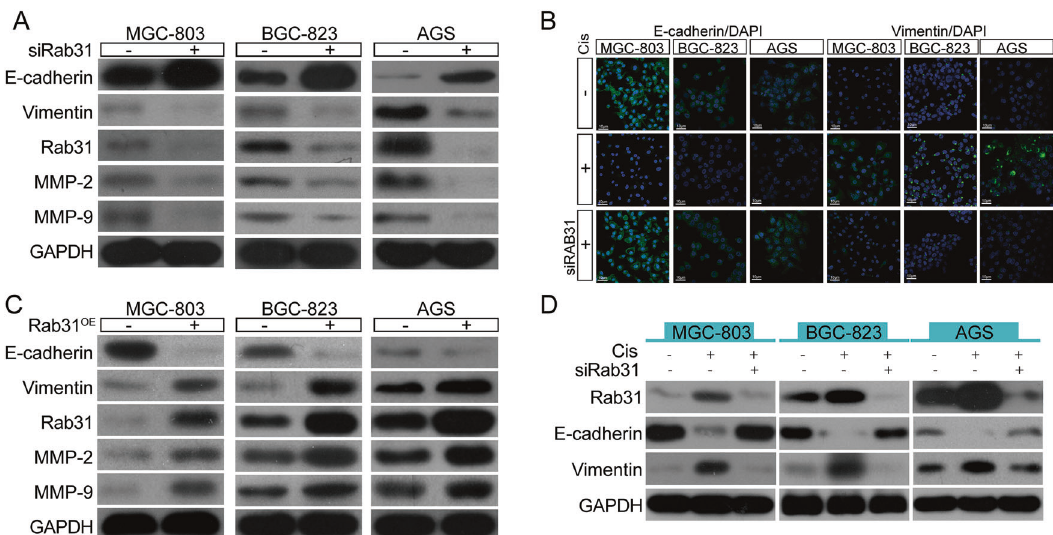
Fig. 3 Rab31 promotes metastasis and depresses cisplatin sensitivity via EMT. A STAD cells were transfected with control siRNA and Rab31 siRNA for 48 h, and the expression of indicated proteins were detected by western blot. B Expression of E-cadherin and vimentin in control group, cisplatin group and Rab31 siRNA plus cisplatin group was analyzed by immuno fl uorescence. Scale bar: 10 μ m. C STAD cells were transfected with empty vector and Rab31 for 48 h, and the expression of indicated proteins were detected by western blot. D EMT markers in control group, cisplatin group and Rab31 siRNA plus cisplatin group were detected by western blot.